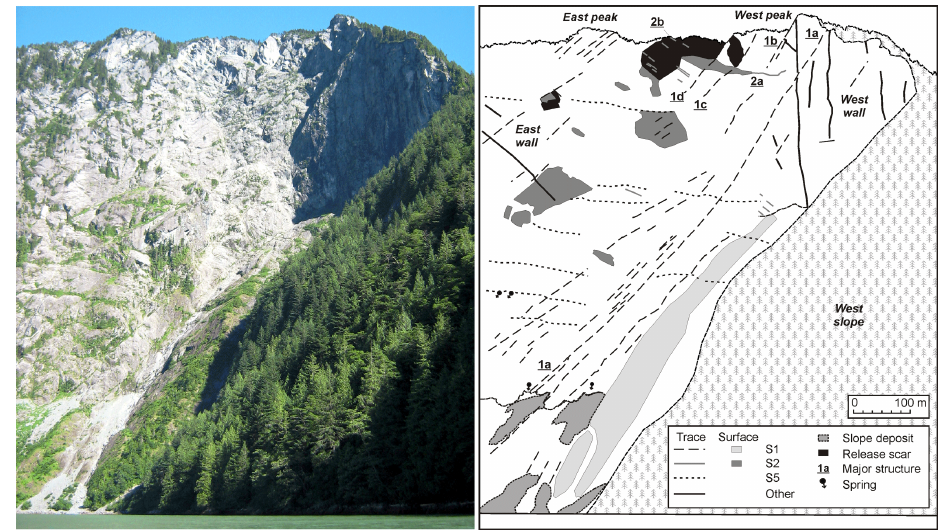
Figure 7. Left: oblique view of the rock slope. Right: map showing major structures exposed in the slope.